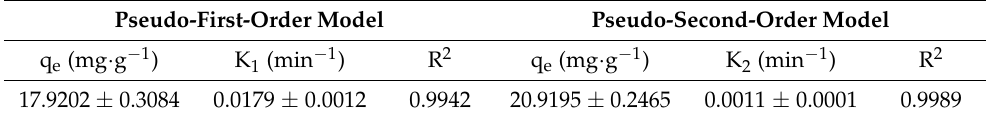
Table 3. Kinetic parameters of phosphate adsorption by LA-CZ.